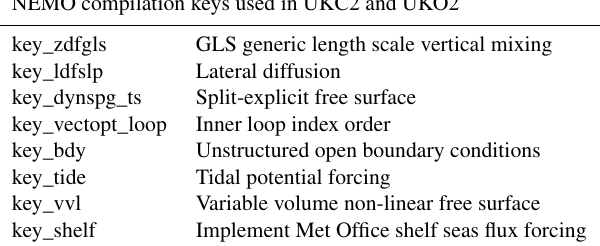
Table C5. Summary of NEMO compile keys used in the UKC2